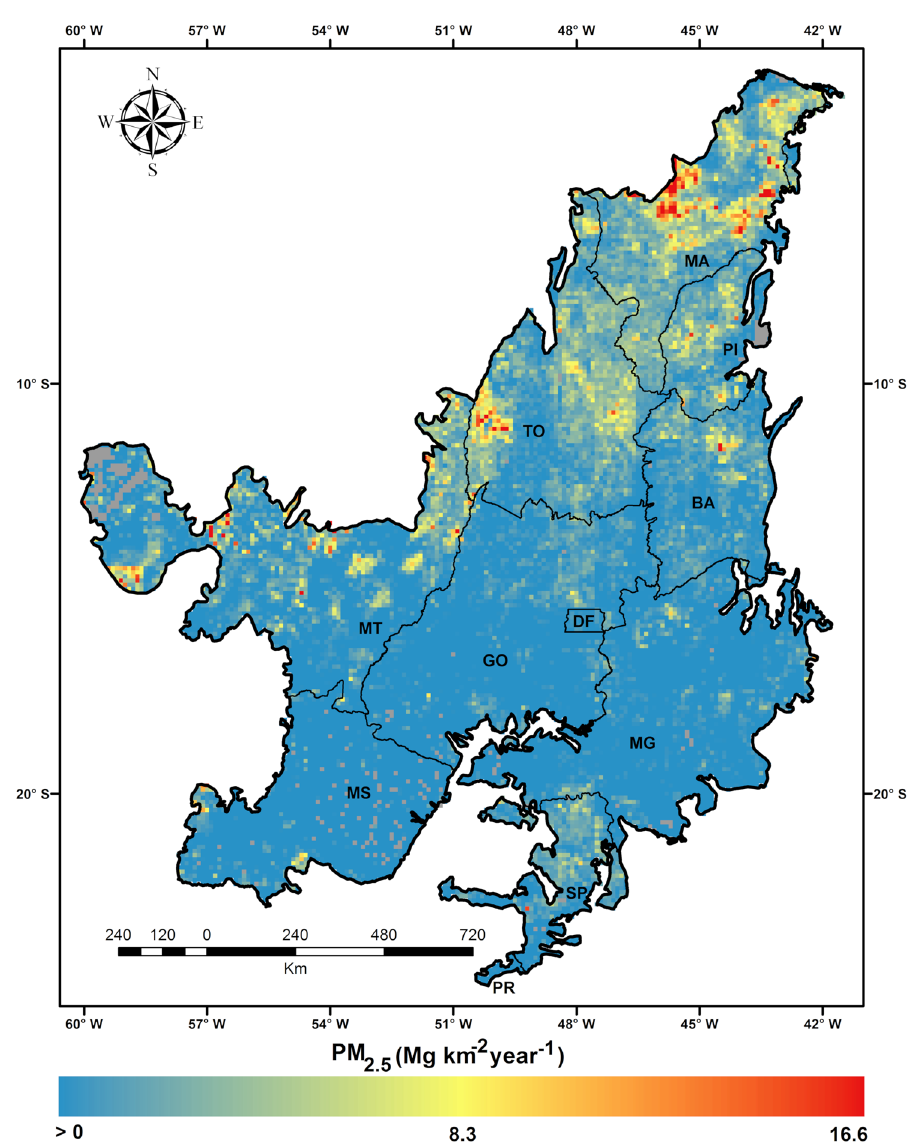
Figure 6. Spatial distribution of the annual average PM 2.5 associated with fires in the Cerrado biome during the 2002–2017 period based on PREP-CHEM-SRC 1.8.3 estimates. Gray pixels presented zero PM 2.5 emission associated with fires during the entire 2002–2017 period.